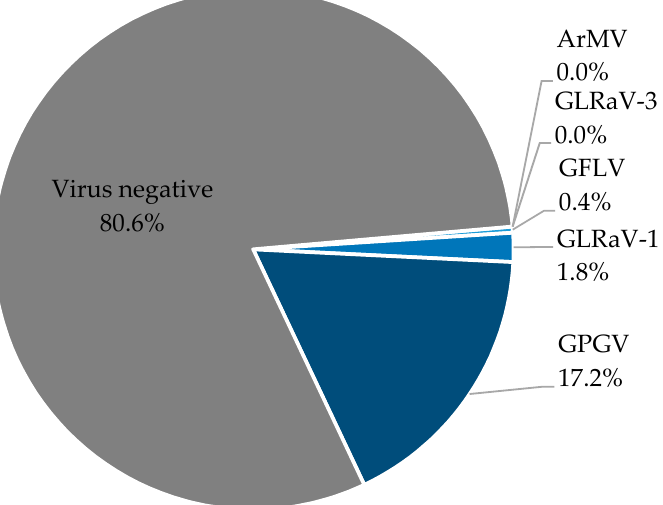
Figure 2. Grapevine Pinot gris virus (GPGV) was detected in 17.2% of scion samples from 2018. The graph represents the ELISA results from all scion material tested in 2018. Each sample was tested for the four official viruses ArMV, GFLV, GLRaV-1, and GLRaV-3. Samples were additionally tested for Grapevine Pinot gris virus (GPGV) (dark blue). None of the samples was positive for ArMV or GLRaV-3.